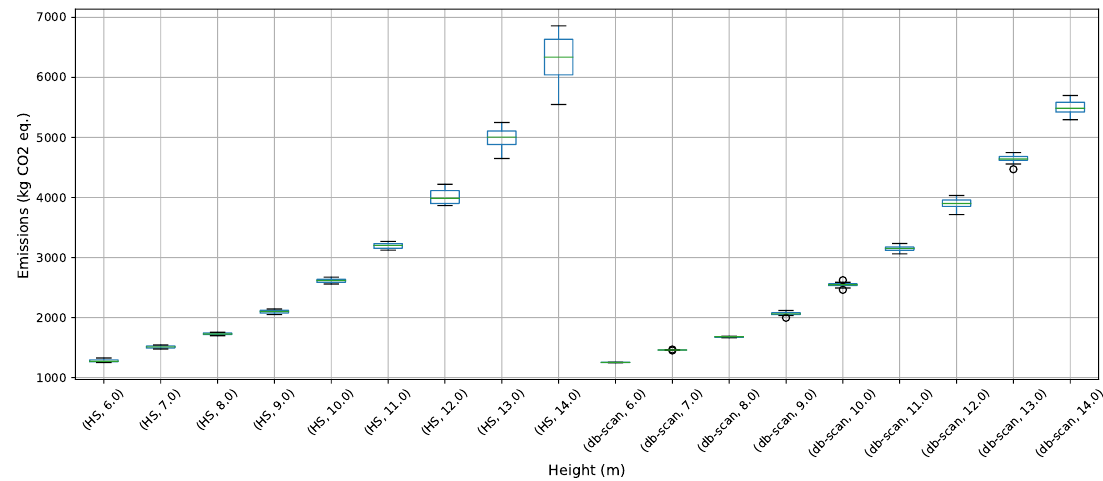
Figure 13. Emission box-plots, comparison between db-scan PSO and HS